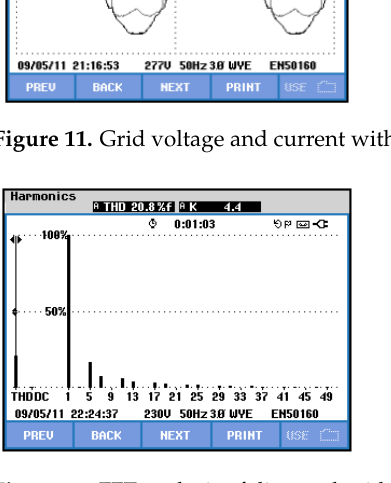
Figure 13. Grid voltage and current for inductive load in grid-connected mode. Figure 14. FFT analysis of compensated grid current with inductive load.